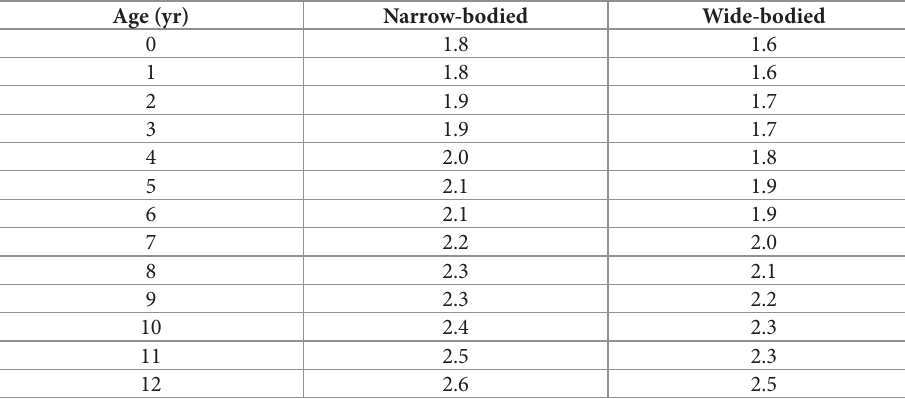
Table 4. Estimated monthly lease rates expressed as % of current market value Age (yr) Narrow-bodied Wide-bodied